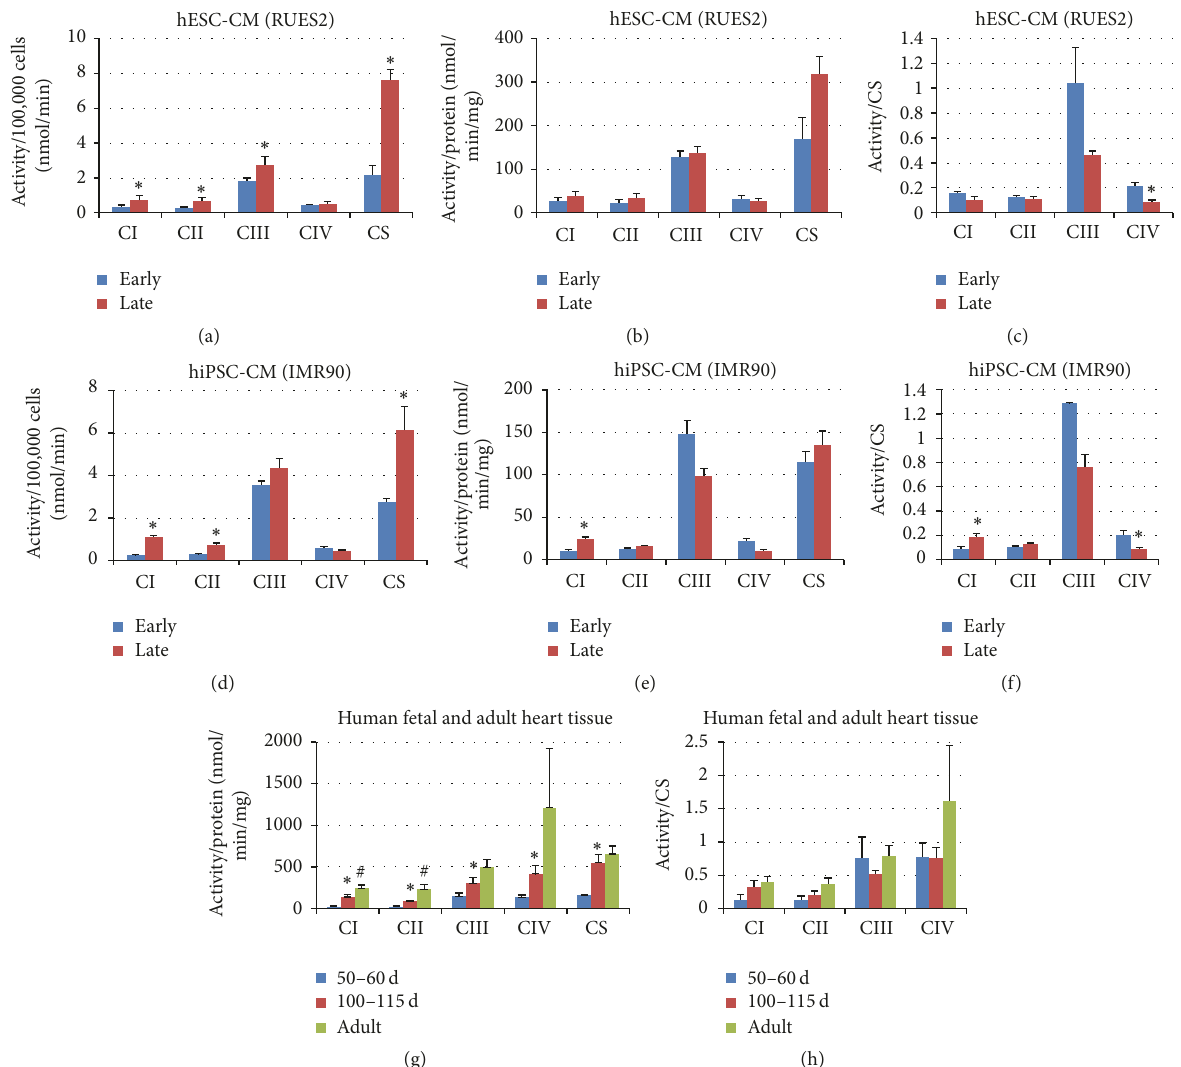
Figure 5: Respiratory complex activities in hESC-CM (a–c), hiPSC-CM (d–f), and human heart tissue (g, h). Respiratory complex activities are measured in 100,000 cells of either hESC-CM (hESC-CM) or hiPSC-CM (d), normalized to total protein (b, e) or citrate synthase activity (c, f). Respiratory complex activities are measured in fetal hearts (50–60 days and 100–115 days), and adult heart tissue lysate, normalized to protein amount (g) or citrate synthase activity (h) of the corresponding samples. ∗ 𝑝 < 0.05 versus early CM or 50–60 dCM. # 𝑝 < 0.05 adult versus 100–115d; 𝑛 = 3 –5 biological